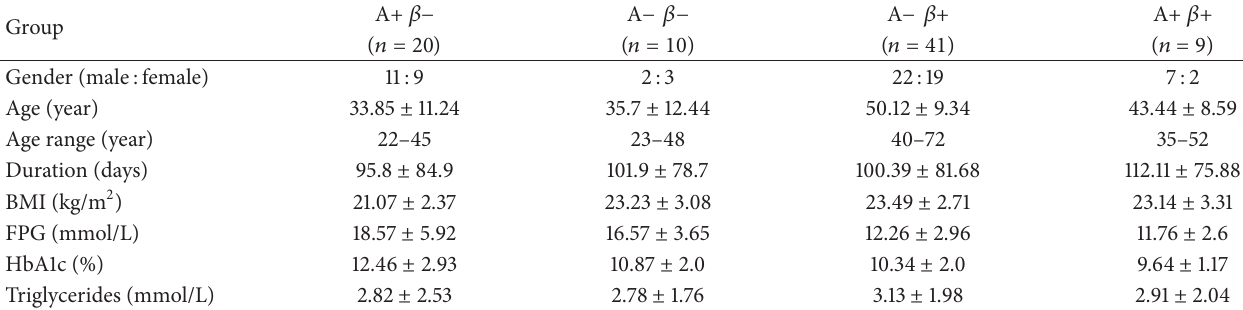
Table 2: Ketosis prone diabetes clinical